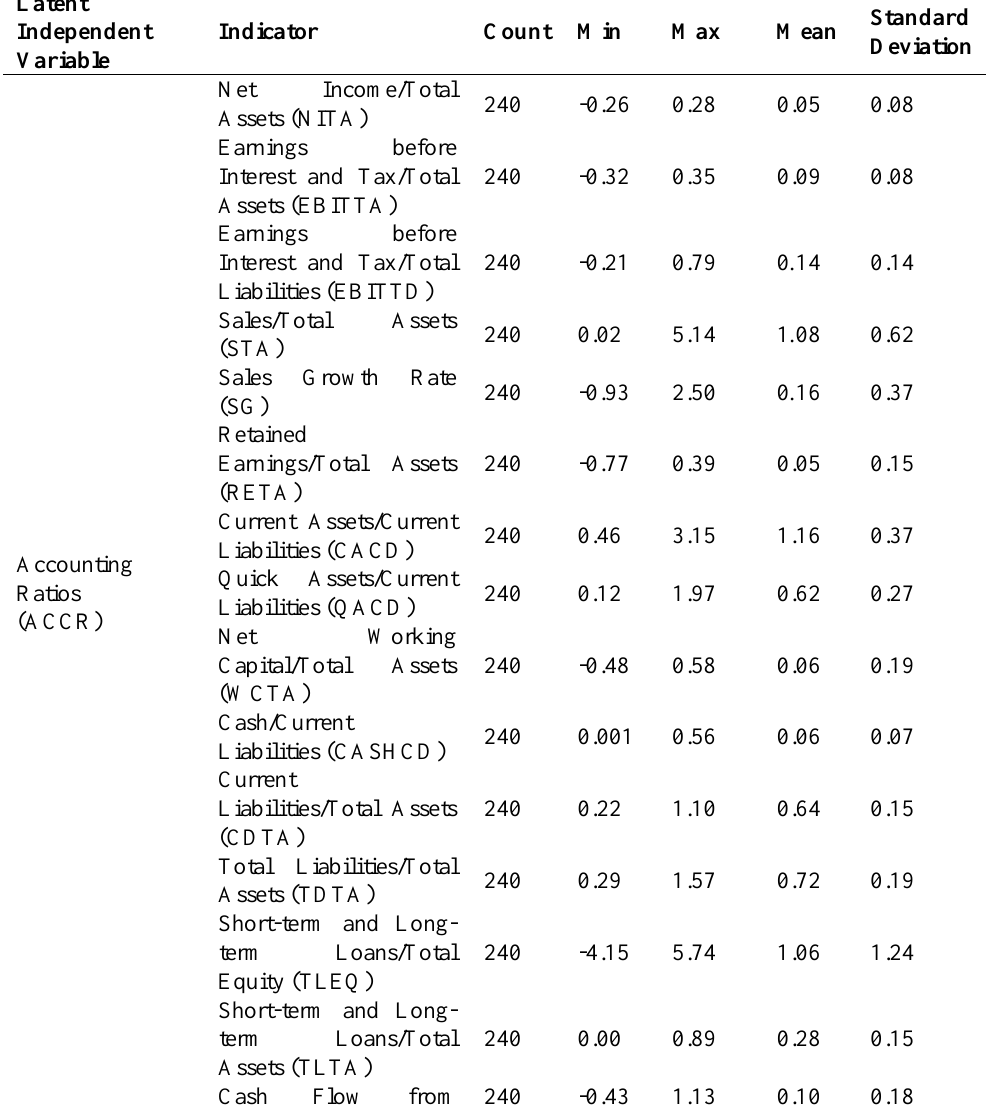
Table (5). Descriptive Statistics for Indicators of Latent Independent